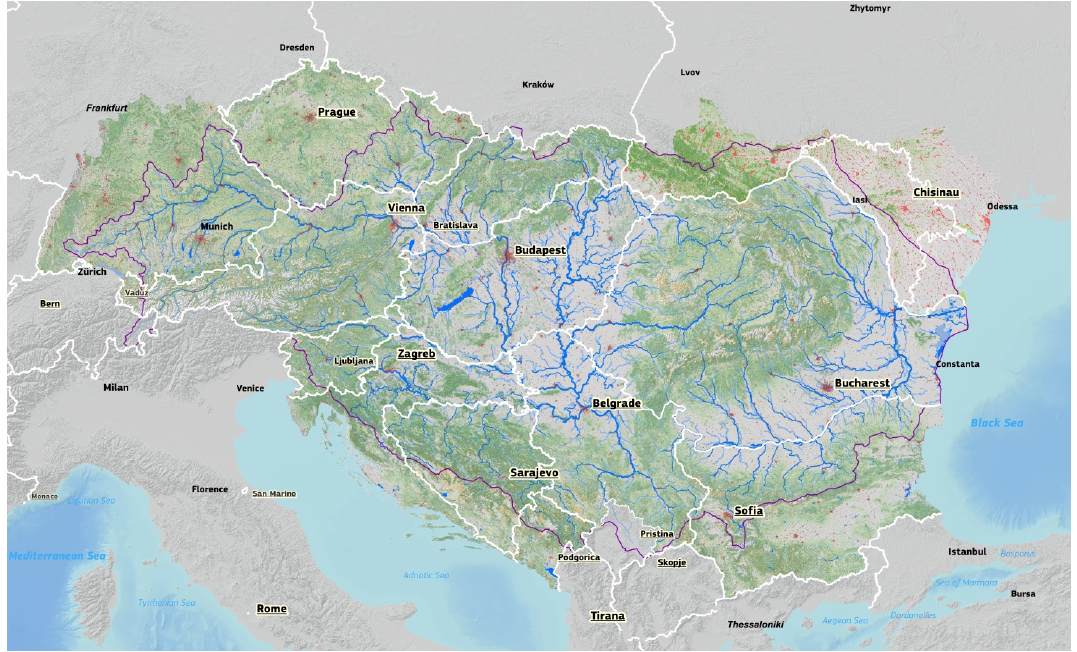
Figure 1. Territorial dimension of the EU Strategy for the Danube Region. Source: